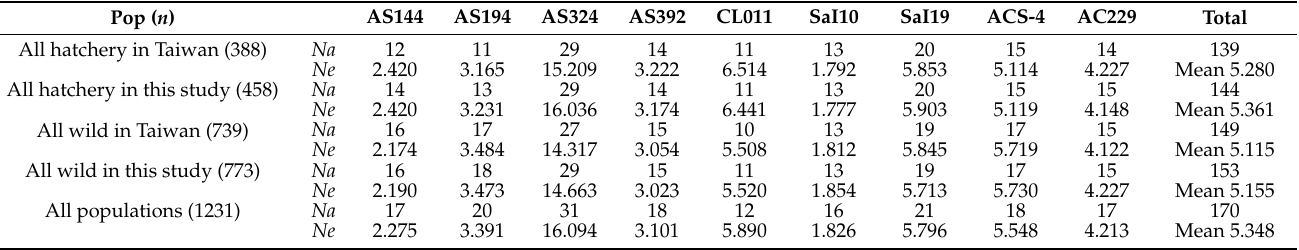
Table 3. Number of alleles ( Na ) and effective alleles ( Ne ) at nine microsatellite loci in 19 black sea bream